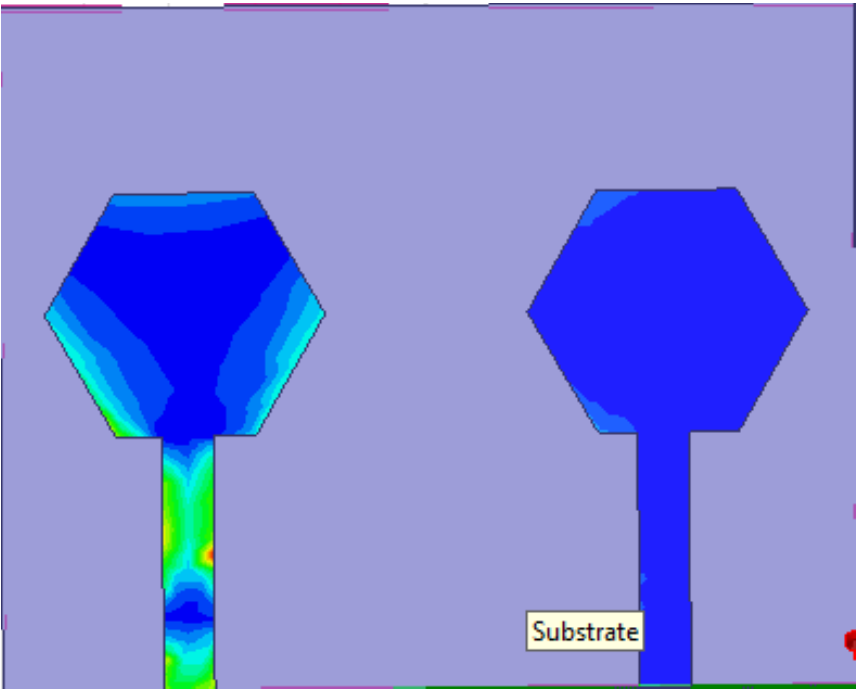
Figure 7. Current distribution conventional hexagonal antenna array.